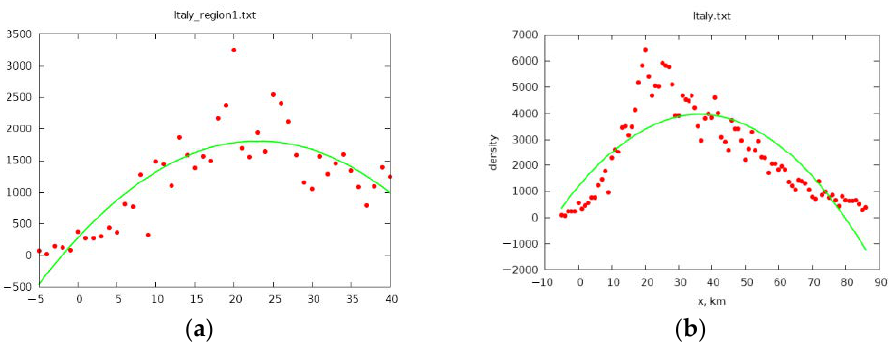
Figure 4. Maximums of infection for ( a ) the first band and ( b ) all of Italy that correspond to maximums of parabolas. For Lombardy ( a ) the maximum is near the point 21 which means March 22 and for all of Italy ( b ) it is near the point 39 which means April 9.